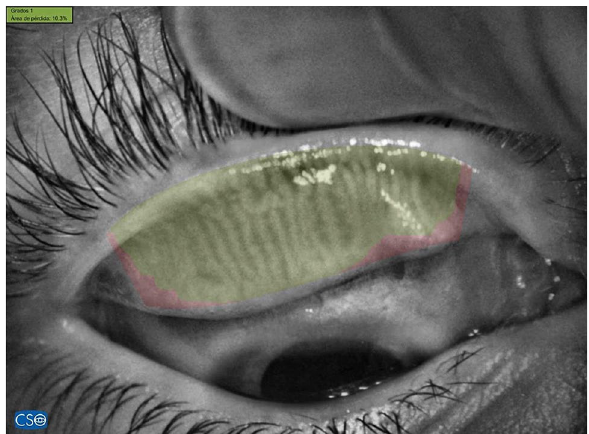
Figure 2. ( A ) Morphological characteristics of Meibomian Glands. (A) distorted (Distorted gland do not follow the parallel course of normal glands The distortion is less than that of a tortuous gland). (B) tortuous. (Tortuous gland must have at least one prominent tortuous configuration in the gland) (C) thinned. (Thinned/Attenuated glands have a width that is less than half the width of a normal gland) (D) thickened. (Thickened glands have a width that is equal to or more than twice the width of a normal gland). ( B ) Morphological characteristics of Meibomian Glands. (A) shortened. (The gland does not extend to its all normal length) (B) Drop out. (An empty space where a gland should have been observed. This would form part of the total dropout area along with areas from shortened glands, if such gland is present. (C) ghost. (Pale glands with absence of the normal meibomian gland architecture) (D) hooked. (Hooked glands curl back at the distal end, resembling a fishhook. ( C ) Morphological characteristics of Meibomian Glands. (A) tadpoling (Glands are thick at the eyelid margin but taper and thin out distally). (B) abnormal gap. (Gaps are normal spaces between glands. Abnormal gaps are present when two adjoining glands are pushed aside such that the width of the gap between them is at least twice that of a normal gland (C) fluffy areas (Amorphous white substance in areas where normal glands should have been present. Individual glands with sharp borders or normal architecture cannot be visualized) (D) no extension to lid margin (Gland stops short of the lid margin). ( D ) Morphological characteristics of Meibomian Glands. (A) overlapping (One gland crossing over adjoining glands. Can be under or over.